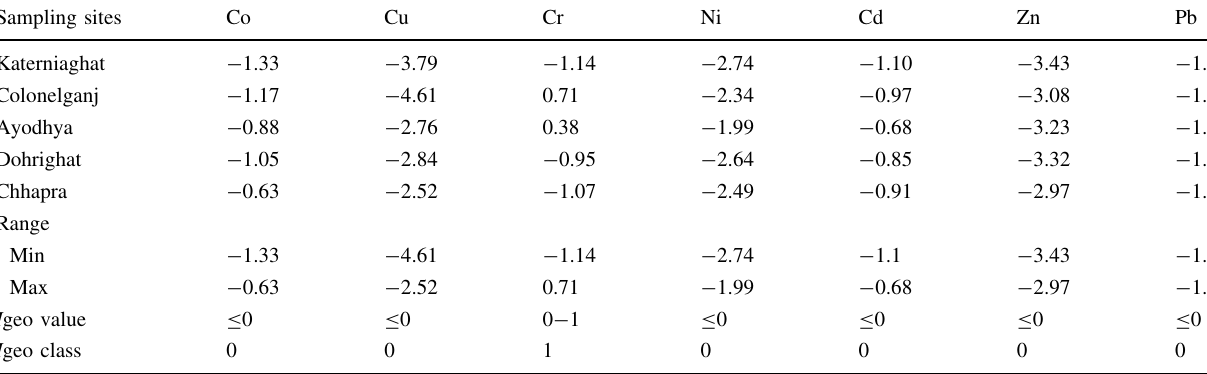
Table 5 Geo-accumulation index ( I geo) of the Ghaghara river sediment Sampling